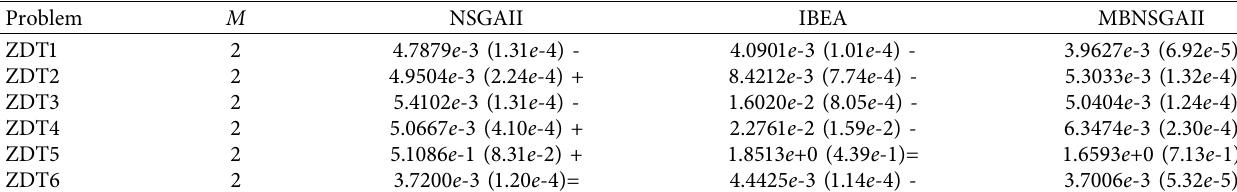
Table 2: Experimental results of IGD on ZDTs (mean and standard